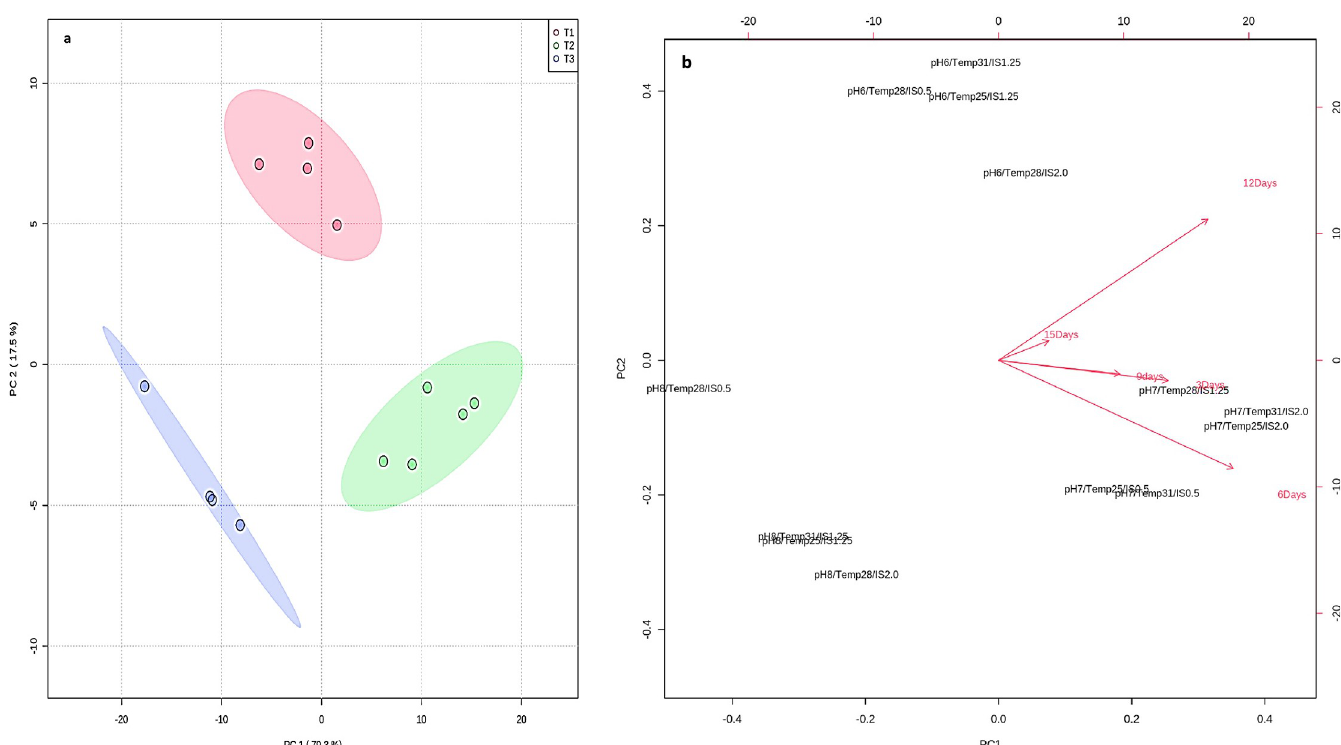
Fig 8. a, b. Principal component analysis of PBZ degradation by strain M6 under different time intervals. Score (a) and Loading plot (b) of different parameters analysed three treatments i.e. pH, Temp, inoculum size, under PBZ contamination. The x-axis indicates principal component 1 (PC1) and the y-axis indicates principal component 2